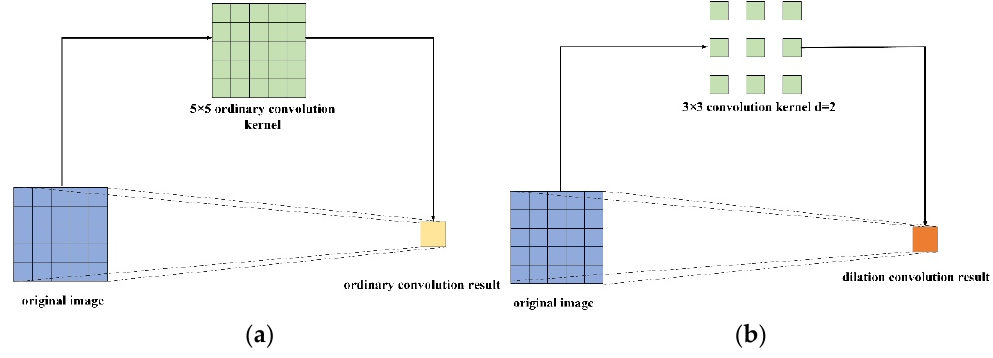
Figure 3. Dilation convolution operation. ( a ) The process of 5 × 5 general convolution Convolve. ( b ) The process of 3 × 3 dilated convolution (d = 2). ( b ) The process of 3 × 3 dilated convolution (d =